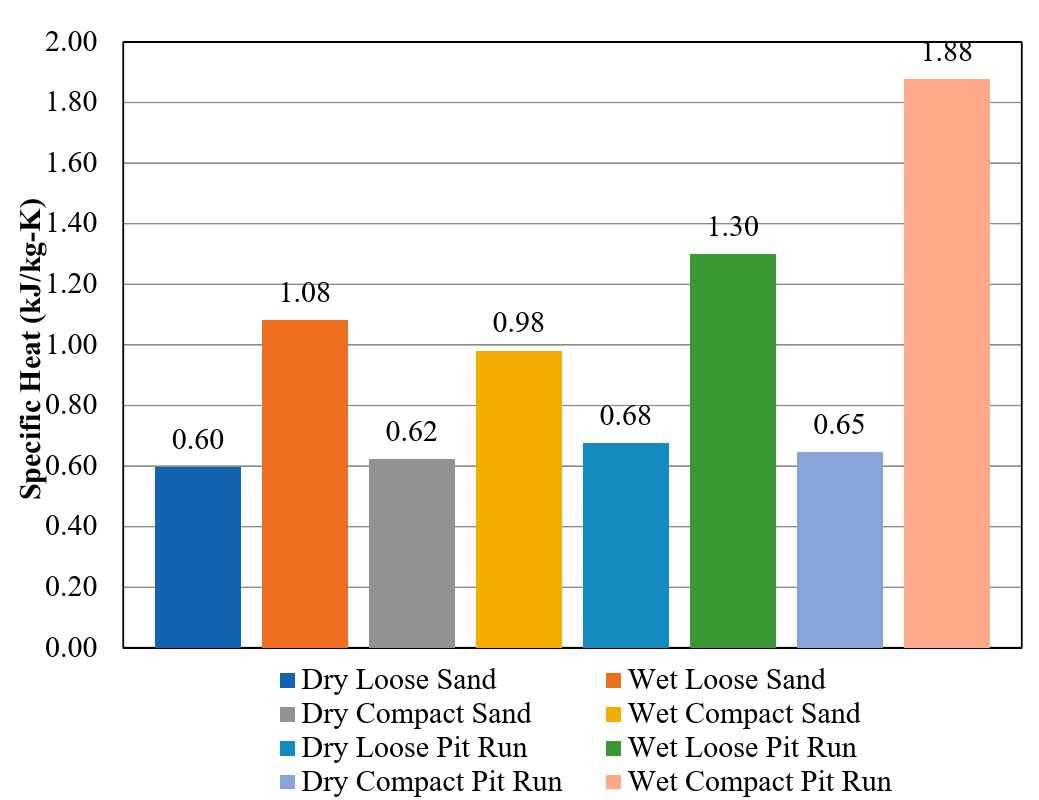
Figure 7. Specific heat of soil samples.